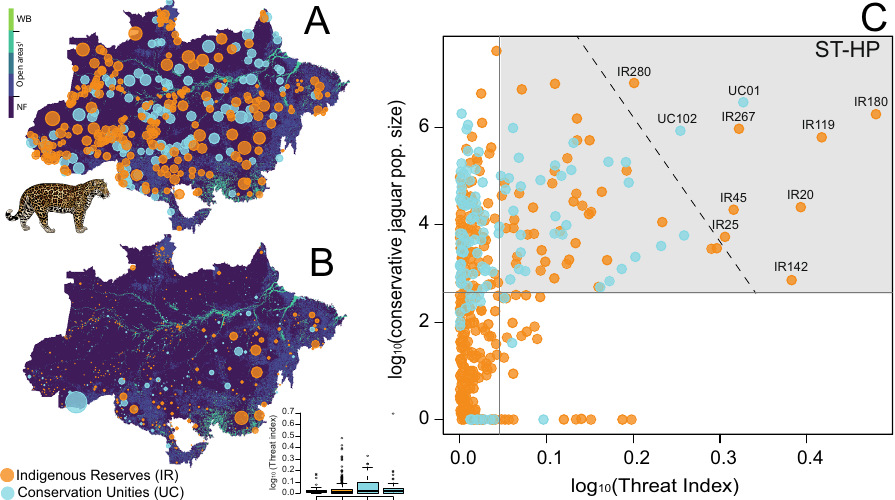
Fig. 3 Jaguar population size, threat index (TI) and prioritization diagram for jaguar conservation across the Brazilian Amazon. Distribution of jaguar population size (log 10 x + 1) inside protected areas ( A ), threat index (TI) and values per protected area type ( B ) and bivariate plot between the threat index and conservative jaguar population sizes inside 447 protected areas across the Brazilian Amazon ( C ). Acronyms are ST-HP: short-term high-priority quadrant (delimited by highlighted gray-frame) and the respective top-ranking 10 areas that should be prioritized in each approach based on the extreme of distribution thresholds by a tangential line. We also identi fi ed additional Amazonian PAs that should be prioritized for jaguar conservation in the short to medium term according to our prioritization quadrants (highlighted gray-frames; see Supplementary Data 3). The background map in ( A ) and ( B ) was produced by the authors and represents the land cover and land use dated from 2019 98 . WB water bodies, NF natural forest. 1 Open areas include non- forest natural vegetation, farming, and non-vegetation areas. For all land cover and land-use classes, see ref. 98 . Fernanda D. Abra kindly provided jaguar drawing used in this fi gure. All other elements in the fi gure were created by the authors using R road network within PAs and buffer zones of 3,947 km), These 10 PAs and their respective buffers experienced 11,179 km 2 of pastures (23.3% of 47,936 km 2 of all pastures cumulative deforestation over 4 years of 1175 km 2 (20.8% of the total amount of deforestation in all wider PAs, amounting to across PAs), and an average HPD of 0.009 (± 0.012) per km 2 5560 km 2 ), 20,941 cumulative fi re hotspots over 5 years (20.6% of compared to an average of 2.14 (±27.46) for all PAs. These areas — comprising eight indigenous reserves and two conservation all 101,804 fi res), contain 269.4 km of roads (6.9% of the total